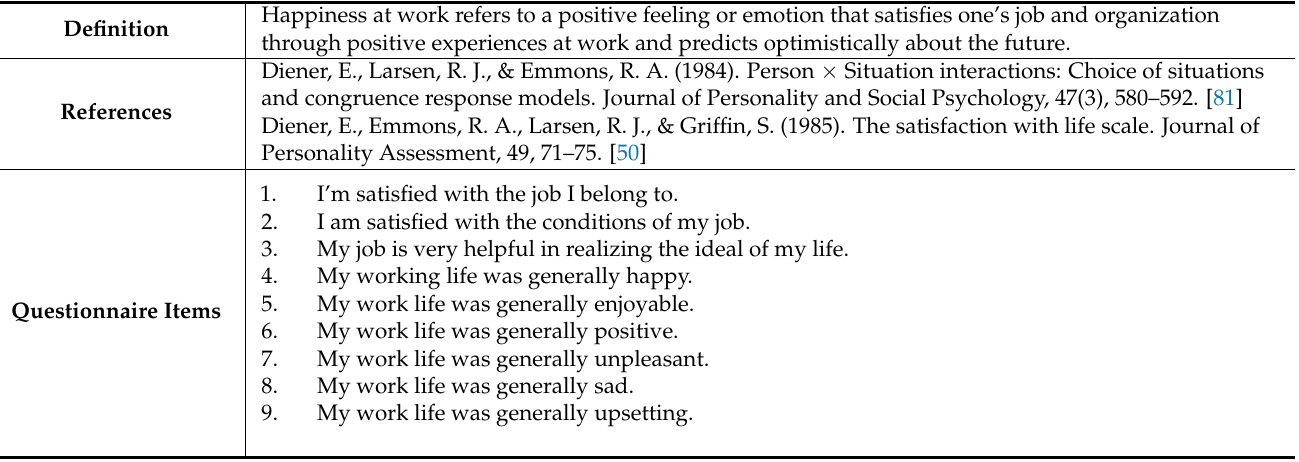
Table A4. Happiness at